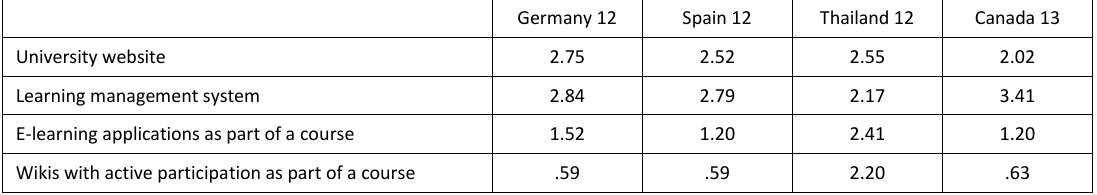
Table 13 . Students’ answers to the question: How often do you use the following for learning/studying?